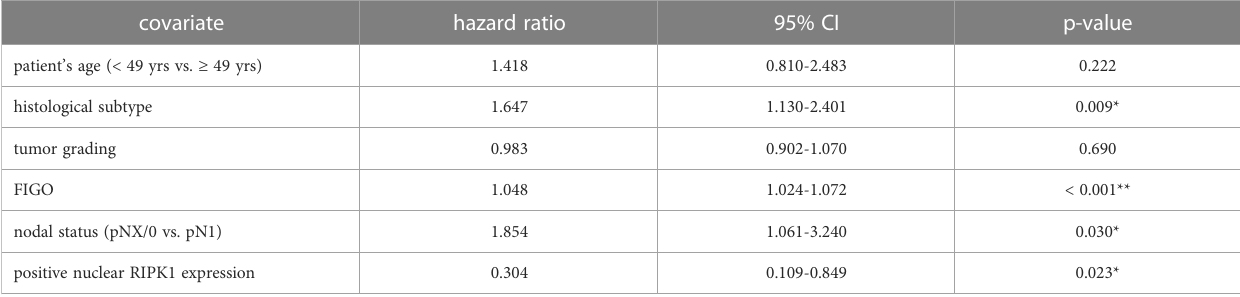
TABLE 3 Multivariate Cox regression analysis of cervical cancer patients ( n = 250) and their clinical and pathological characteristics including nuclear RIPK1 expression regarding PFS. covariate